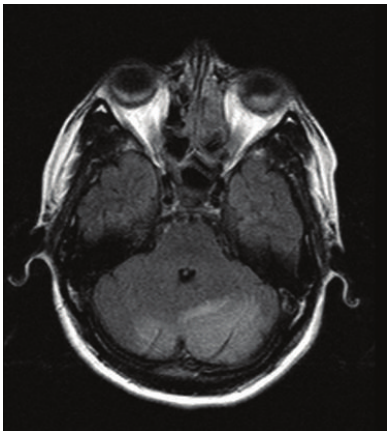
Figure 1: MRI: hyperintense signal involving the white matter typically in occipital regions.